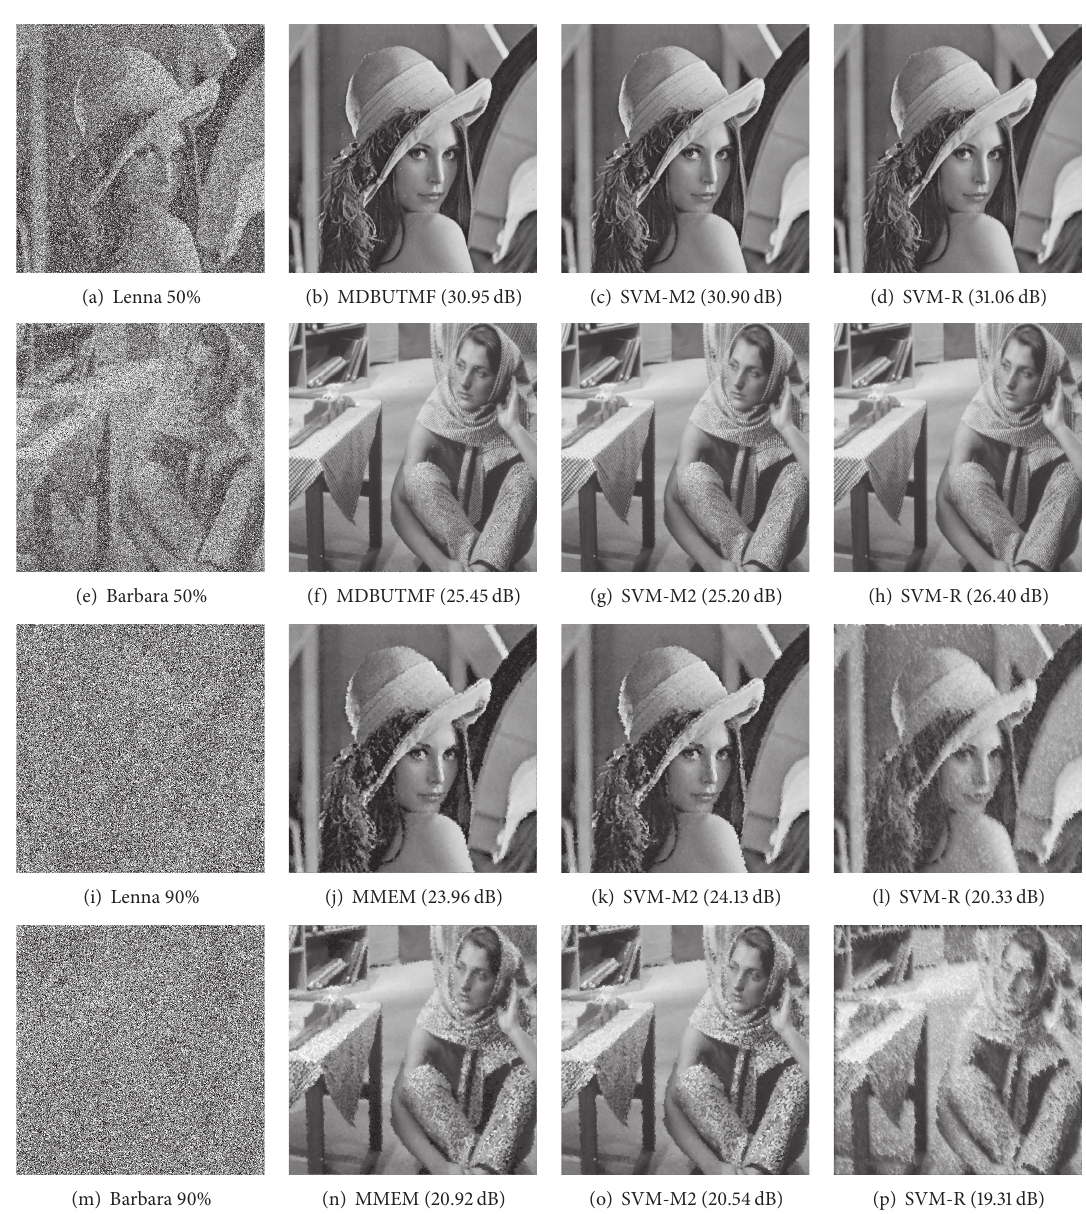
Figure 10: Reconstruction results for the Lenna and Barbara images with 50% and 90% of “salt and pepper” noise, using the MDBUTMF (50%), MMEM (90%), SVM-M2, and SVM-R